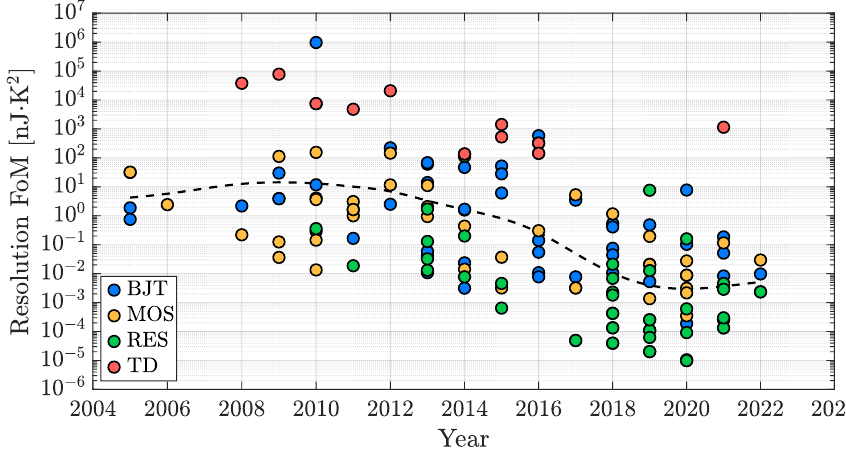
Figure 18. TDC energy efficiency time evolution in the last two